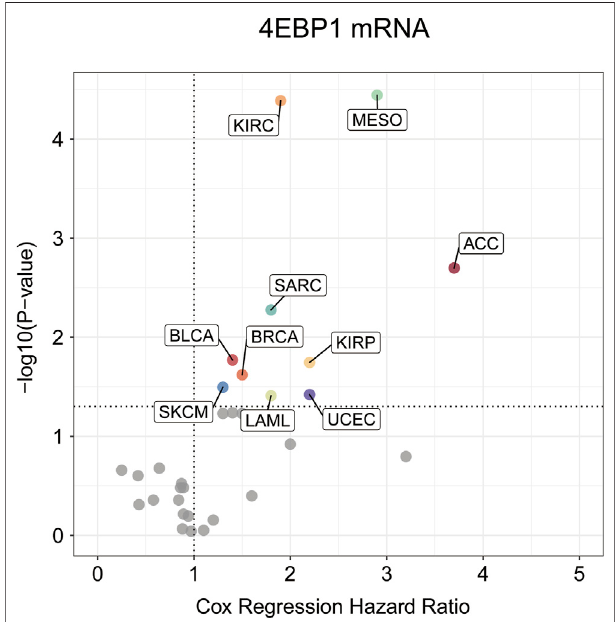
FIGURE 2 | The prognostic signi fi cance of 4EBP1 mRNA in Pan- cancer.The survival hazard ratios of 4EBP1mRNA across all 33 cancer types were assessed using the Cox regression model. The cancer types in which 4EBP1 plays as an important prognostic factor ( p -value < 0.05) were displayed with colored